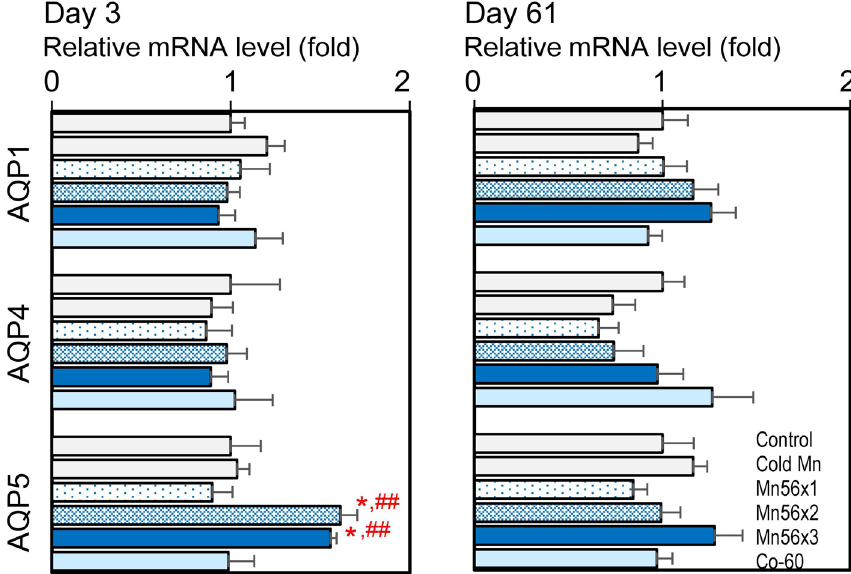
Figure 4. Relative mRNA expression levels of AQP1, AQP4, and AQP5 genes in the lungs of rats on day 3 (left) and day 61 (right) after the exposure to 56 MnO 2 powder (Mn56x1, Mn56x2, Mn56x3), Cold MnO 2 powder (Cold Mn) or 60 Co-γ exposure (Co-60). *p < 0.05 vs. control; ## p < 0.01 vs cold Mn.